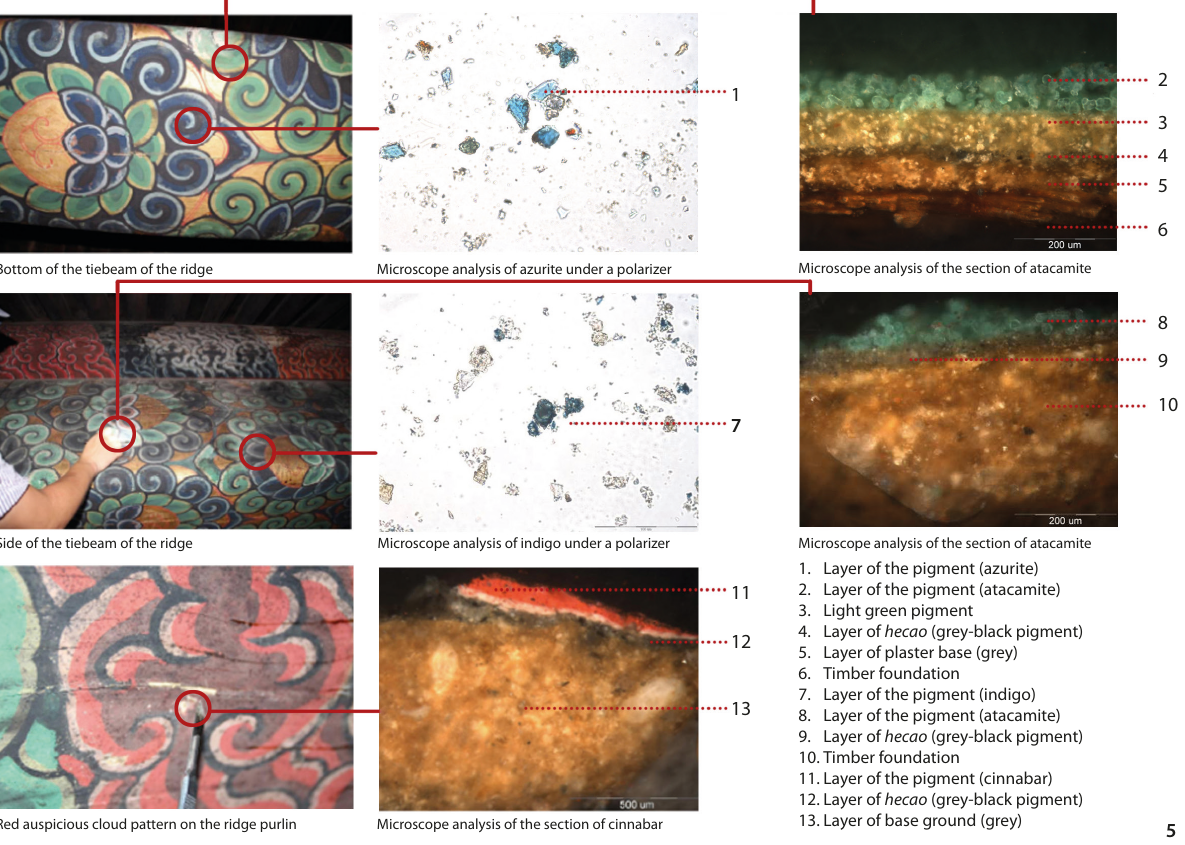
Bottom of the tiebeam of the ridge